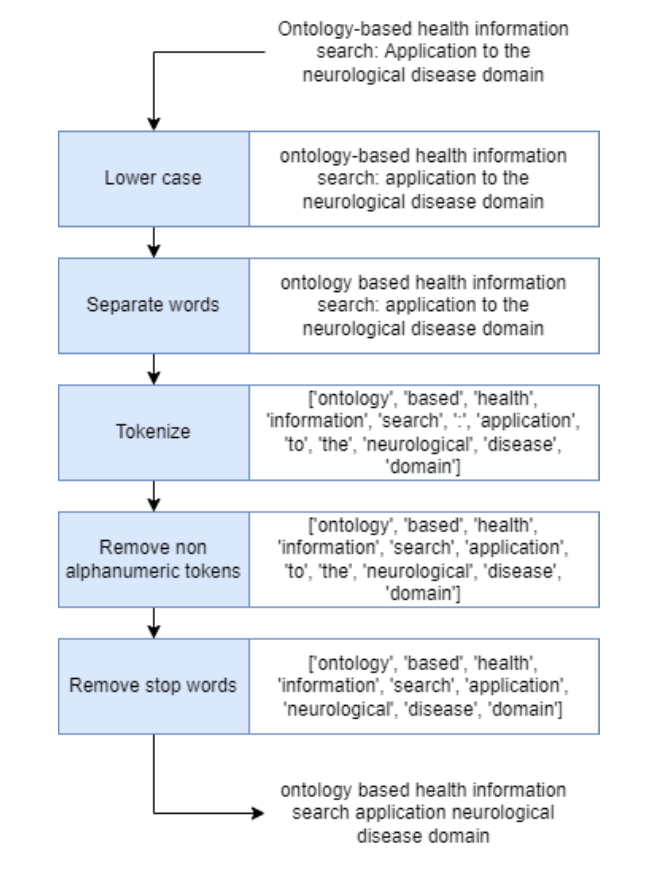
Figure 2. Text processing pipeline execution before comparing publications’ titles and abstracts.